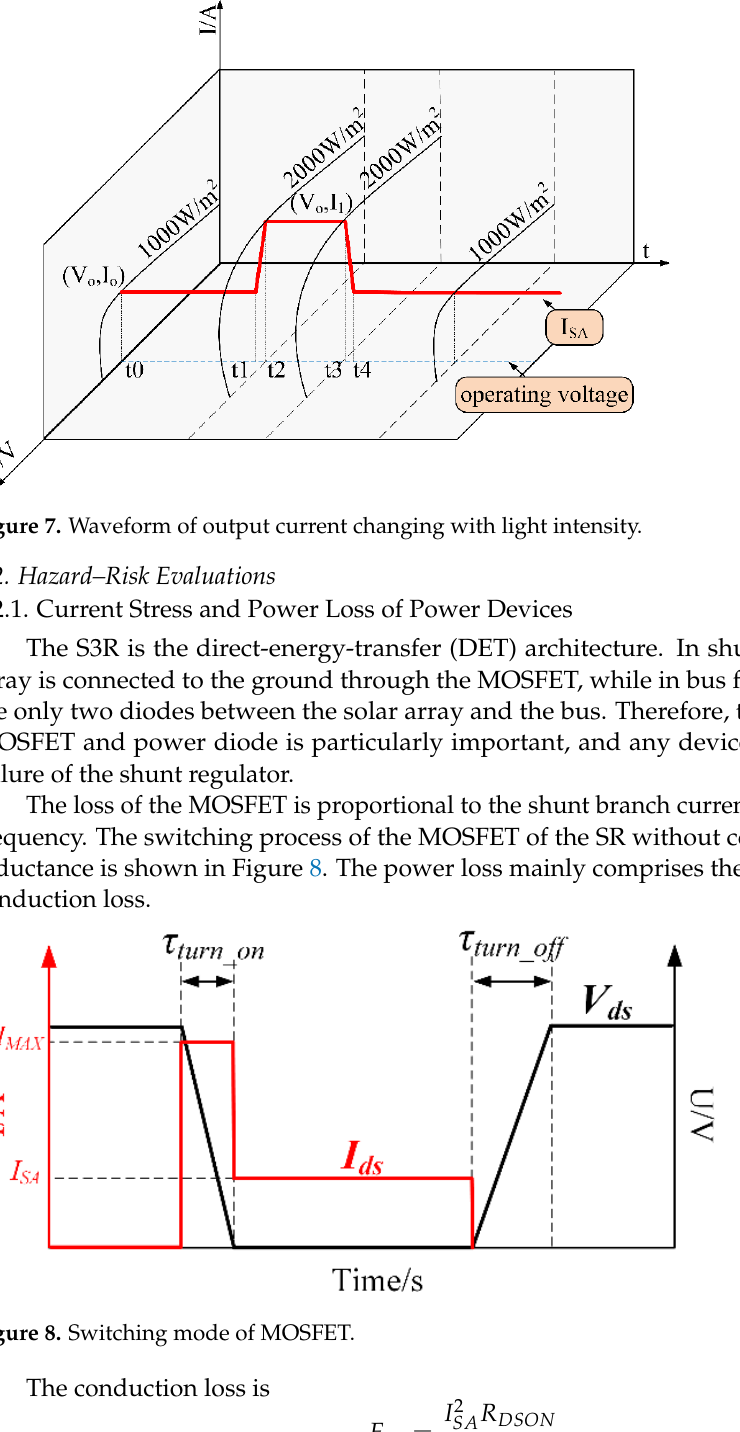
Figure 6. U ‐ I characteristic curves of solar array under different light intensity.